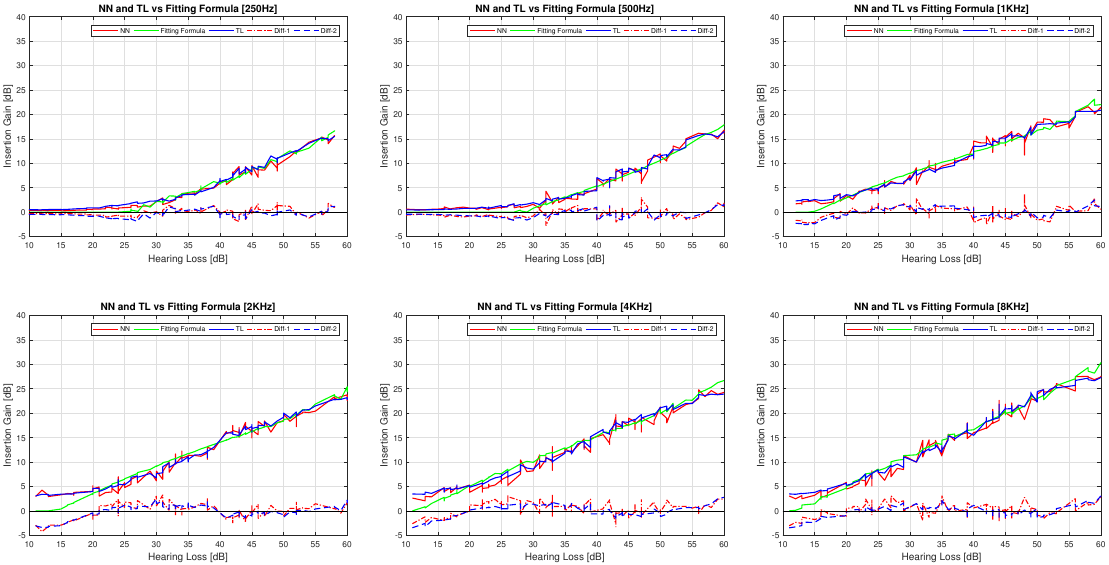
Figure 11. NAL-NL2: Performance comparison for NN and TL vs. fitting formula for the 65 dB of nput level. Comparisons are made for 250 Hz, 500 Hz, 1 KHz, 2 KHz, 4 KHz, and 8 KHz frequencies from top left to right to bottom left to